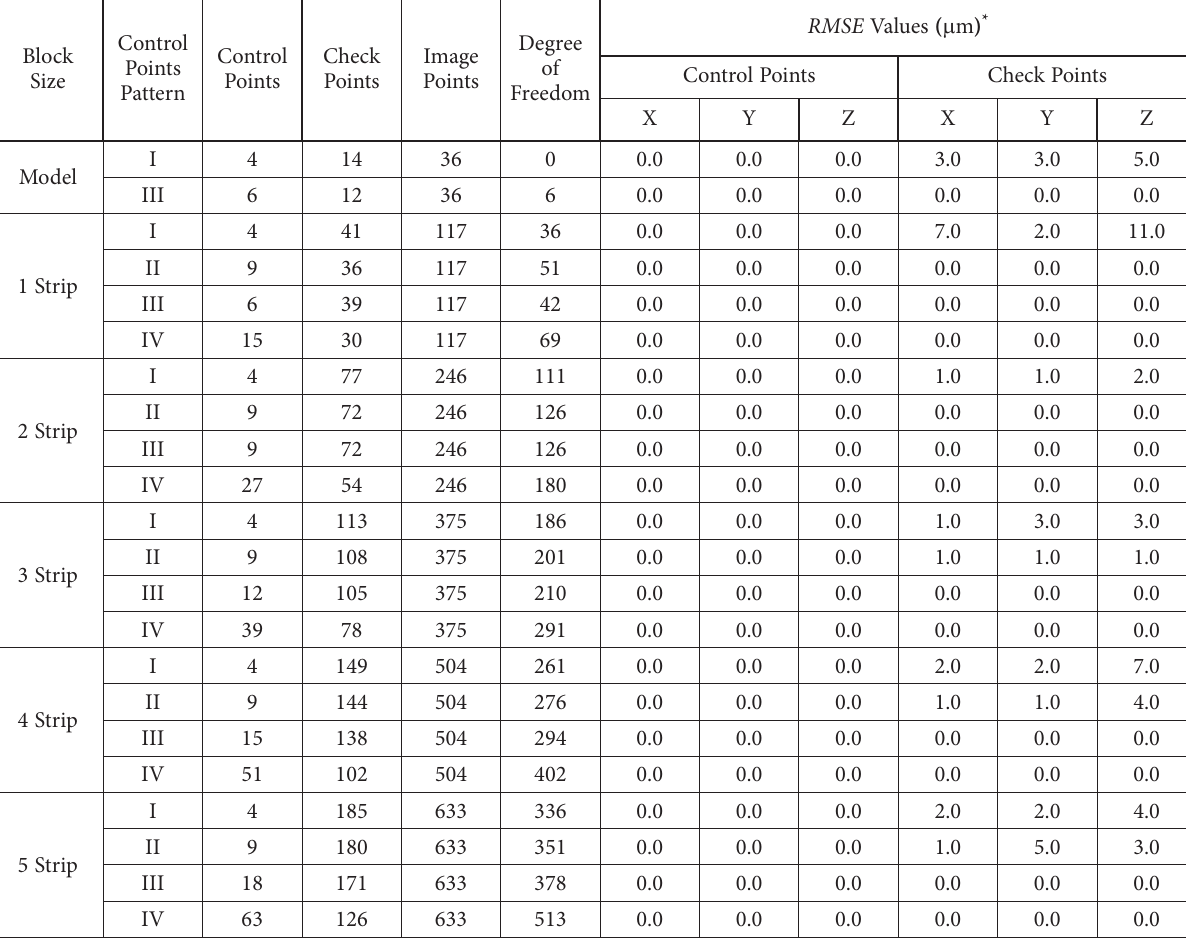
Table 1. Results of testing the geometric error